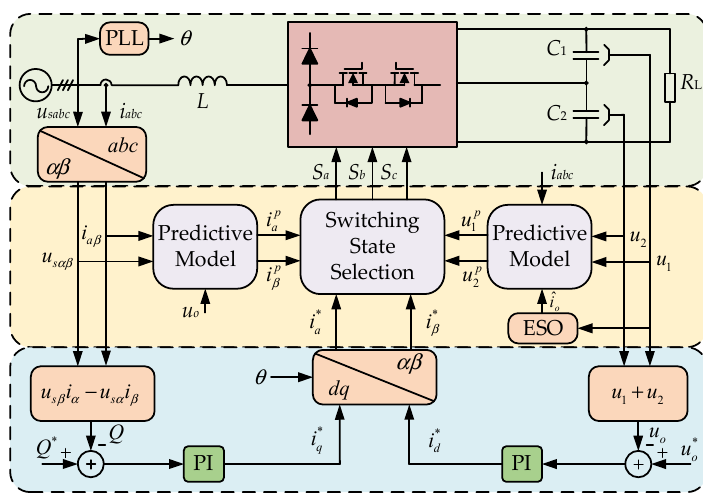
Figure 14. Control block diagram of Vienna recti fi er.